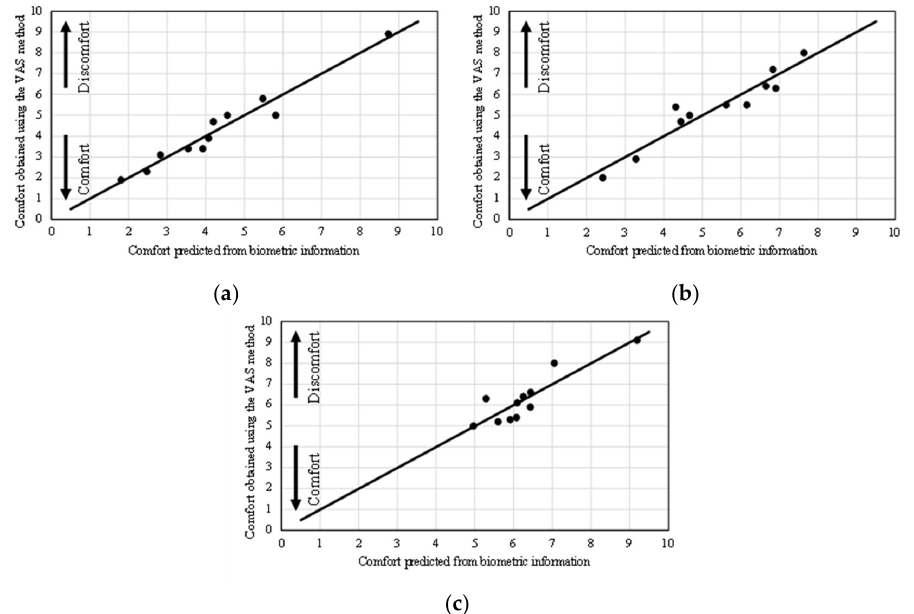
Figure 12. Results of multiple regression analyses. ( a ) 0.2 – 3 Hz; ( b ) 4 – 8 Hz; ( c ) 8 – 20 Hz.